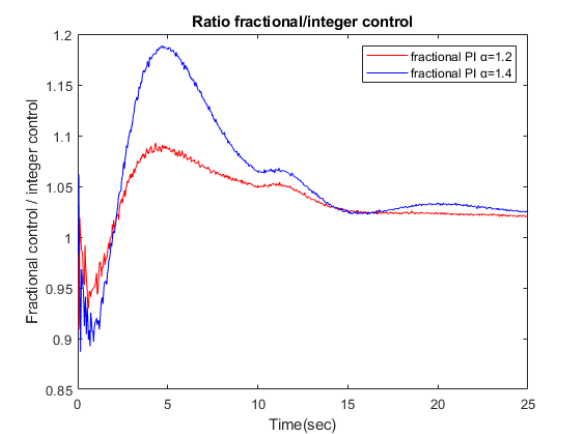
Figure 10. Ratio fractional control/integer control for PI 1.2 versus PI 1.4